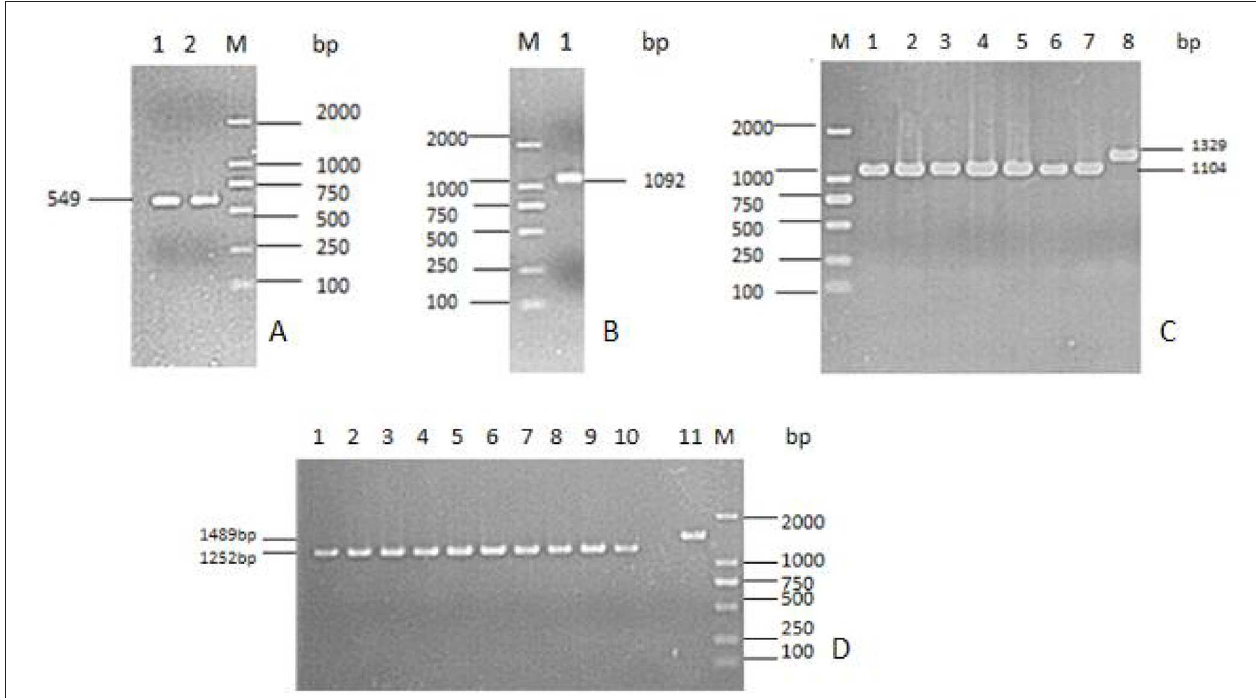
FIGURE 3 | Construction and confirmation of the knockout mutant strain HY9901 1 tyeA . (A) M: DL2000 marker; Lane 1. The 549 bp upstream fragment amplified from genomic DNAs of the strain HY9901 using primer pairs of tyeA-for/tyeA-int-rev; Lane 2. The 543 bp downstream fragment amplified from genomic DNAs of the strain HY9901 using primer pairs of tyeA-int-for / tyeA-rev. (B) M: DL2000 marker; Lane 1. The 1,092 bp fragment amplified from genomic DNAs of HY9901 1 tyeA using primer pairs of tyeA-for/tyeA-rev. (C) M: DL2000 marker; Lane 1–7. The 1,104 bp fragment amplified from genomic DNAs of the HY9901 1 tyeA using primer pairs of tyeA-for/tyeA-rev; Lane 8. The 1,329 bp fragment amplified from genomic DNAs of the wild-type strain HY9901 using primer pairs of tyeA-for/tyeA-rev. (D) M: DL2000 marker; Lane 1–10. The 1,252 bp fragment amplified from genomic DNAs of HY9901 1 tyeA ; Lane11. The 1,489 bp fragment amplified from genomic DNAs of the strain HY9901 using primer pairs of tyeA-up / tyeA-down.